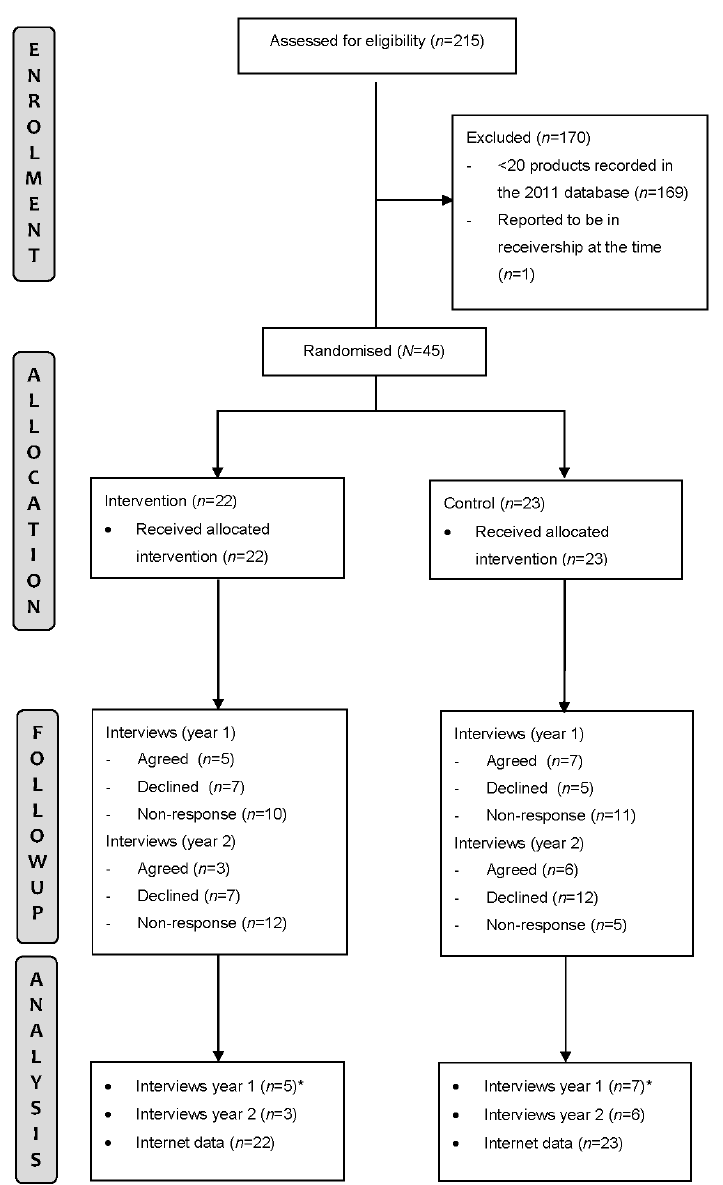
Figure 1. Study flow chart. * Previously analysed and not reported in the present report.